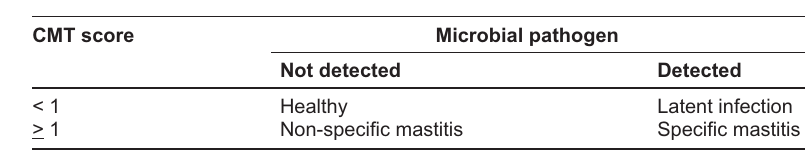
Table-1: Defining udder health status